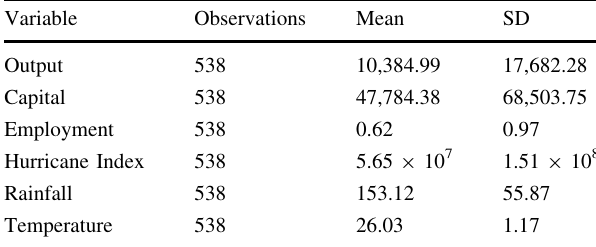
Table 1 Descriptive statistics for the 17 Caribbean countries in the case study